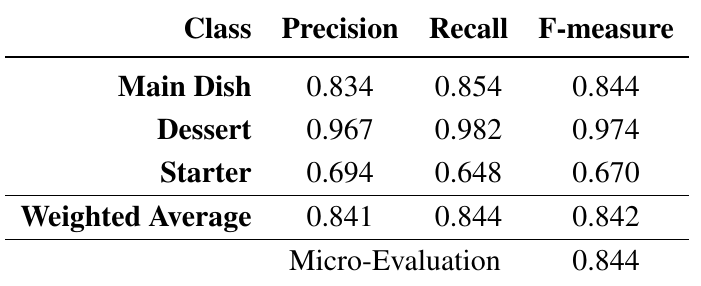
Table 11. Results obtained by system T2 on training corpus on task 2.